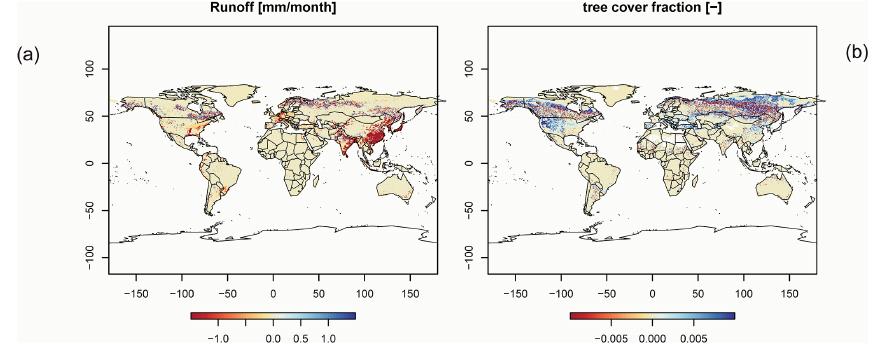
Figure C6. Difference maps of (a) runoff and (b) tree cover